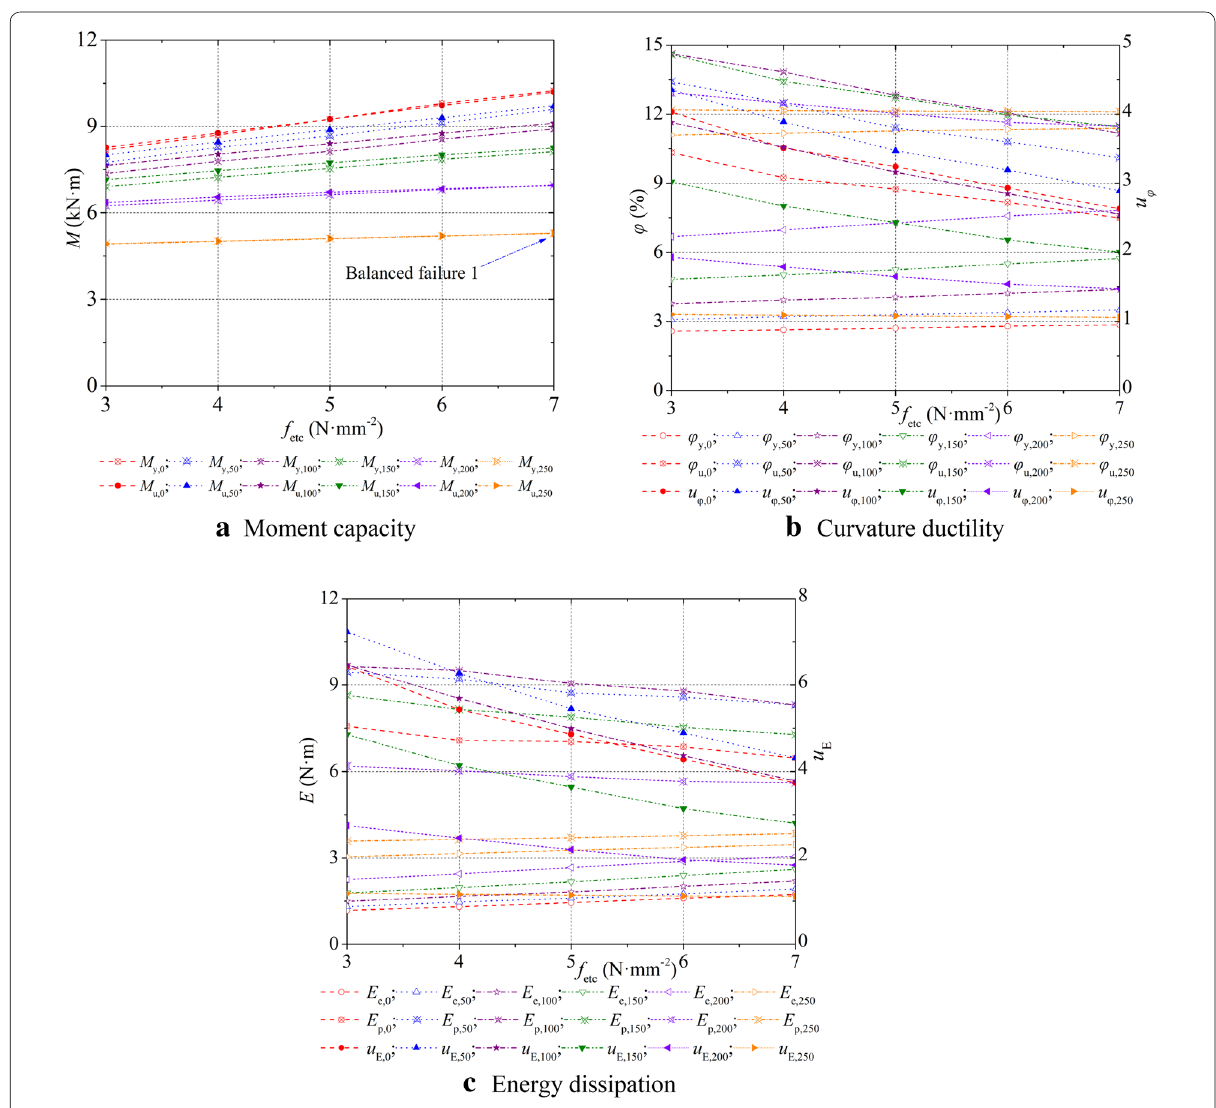
Fig. 16 Influence of concrete strength on moment capacity, curvature ductility and energy